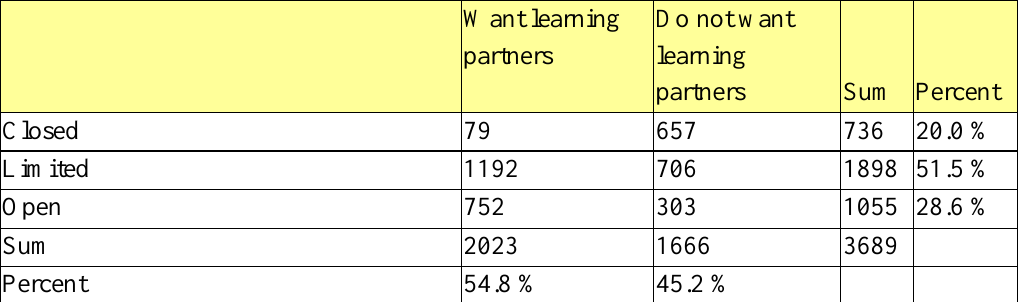
Table 3 Student Preferences regarding Learning Partners and